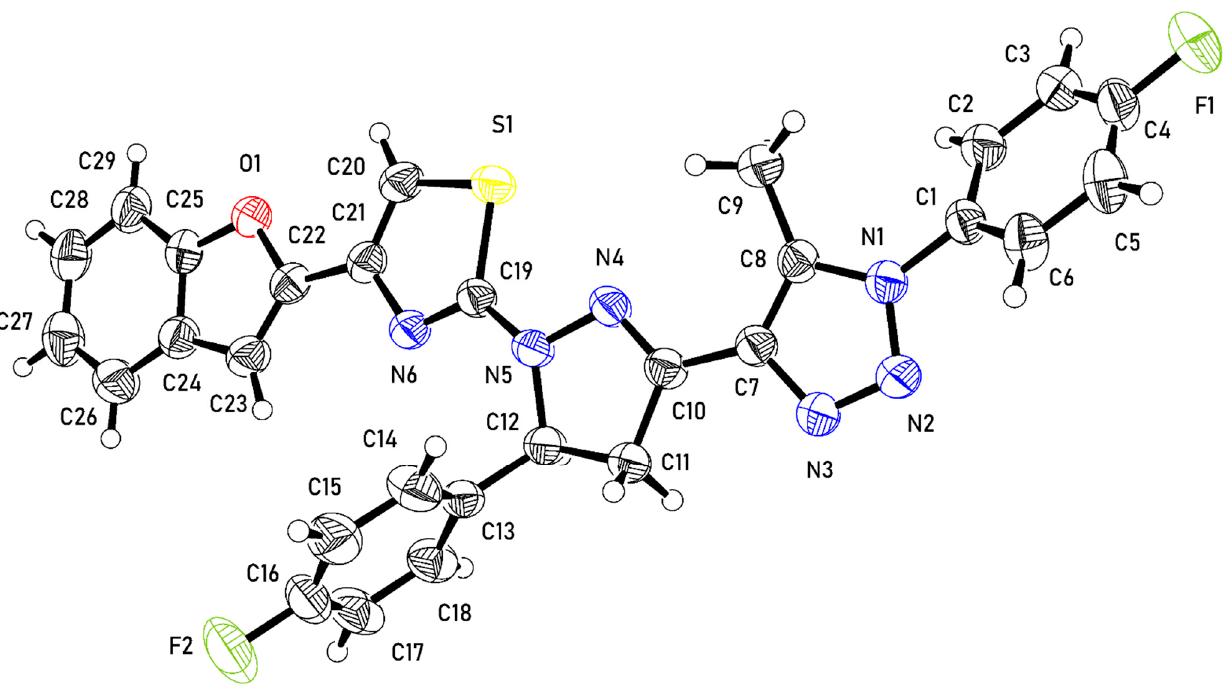
Figure 4. An ortep representation of 9 showing 50% probability atomic displacement ellipsoids.